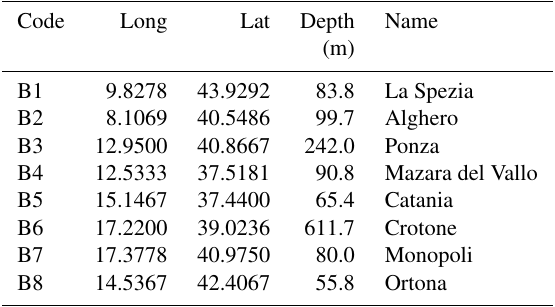
Table 1. Long/lat coordinates and depths of the hindcast locations employed in the study (reference system: